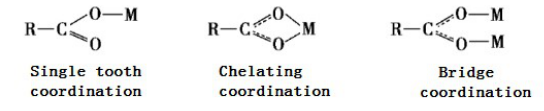
Figure 4. Coordination